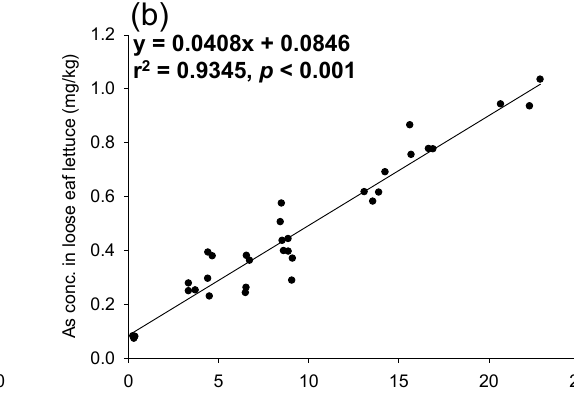
As conc. in soil extracted by 0.5 M NaHCO3